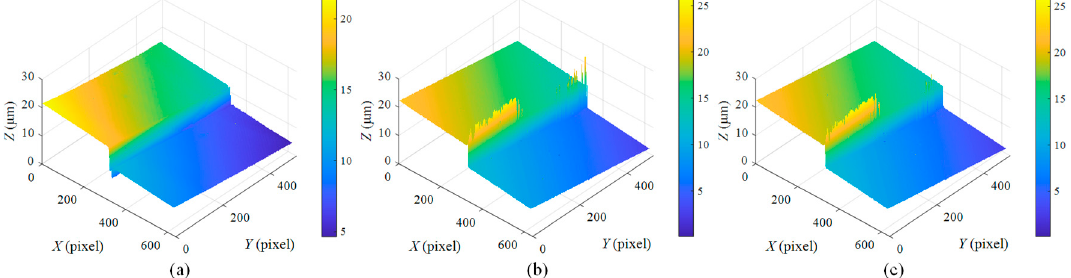
Figure 8. Reconstructed surface profile of 7.347 μ m step height by using: ( a ) centroid method, ( b ) fast Fourier transform (FFT) method, and ( c ) Hilbert transform (HT) method.